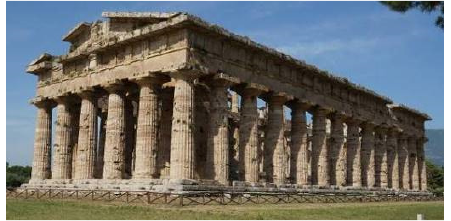
Table 1. Cameras and parameters of the six different